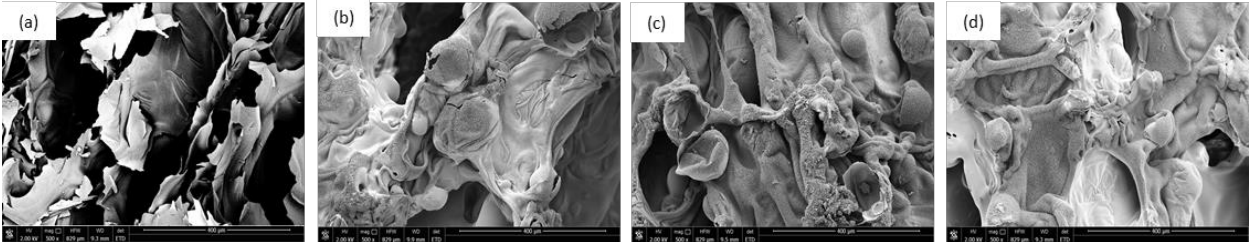
Figure 13. SEM images of char residue of ( a ) PUR_REF, ( b ) PUR_L, ( c ) PUR_L_K, and ( d ) PUR_L_HA (obtained after the cone calorimeter test).